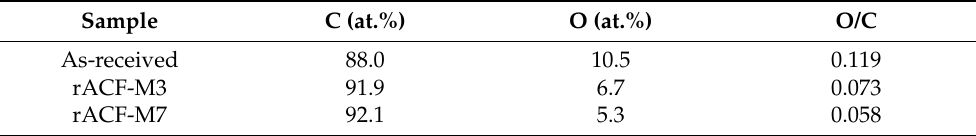
Table 1. Elemental Ratio of Activated Carbon Fibers obtained through Scanning Electron Microscope– Energy Dispersive X-ray Spectroscopy. Sample C (at.%) O (at.%)